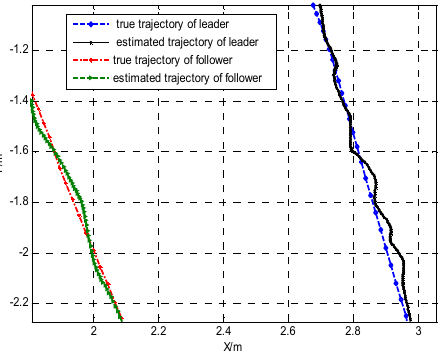
Figure 4. The local enlarged true trajectory and the estimated trajectory for the leader–follower robot team.